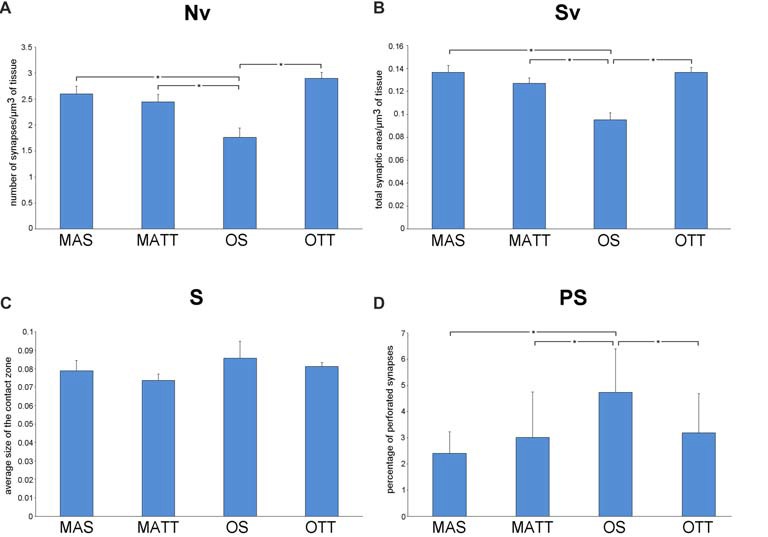
(A–D) Mean values ± SEM of synaptic ultrastructural variables measured in stratum moleculare of hippocampal Ammon’s horn1 pyramidal cells (SMCA1) in MAS, middle-aged running (MATT), OS and old treadmill-exposed (OTT) mice. Nv, numeric density of synapses; Sv, surface density of synapses; S, average size of synaptic contacts; PS, percent of perforated synapses. Asterisk indicates between-group statistically significant differences (p ≤ 0.05; Bonferroni’s post hoc test).